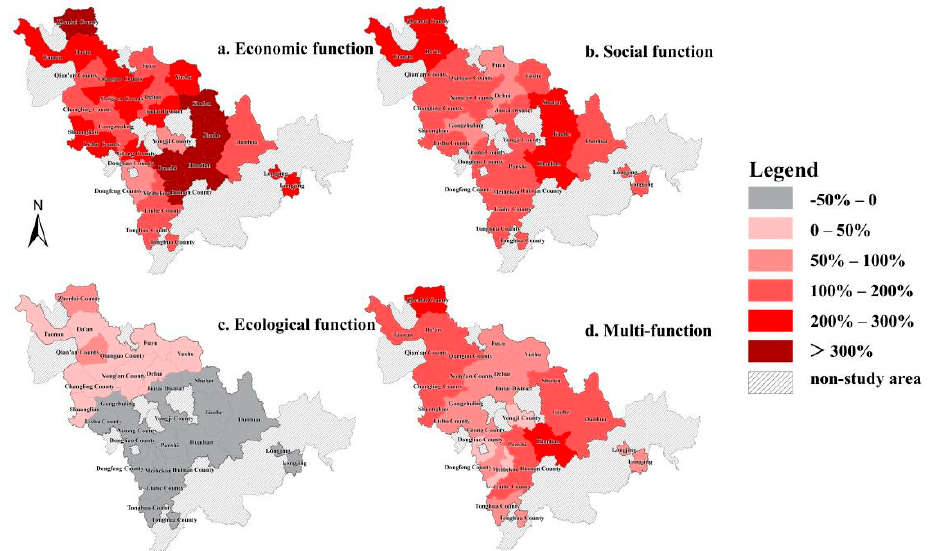
Figure 4. Changes in function of cultivated land in the black-soil breadbaskets of Jilin Province, Northeast China, from 1990 to 2020. ( a ) Economic function. ( b ) Social function. ( c ) Ecological function. ( d ) Multi-function.